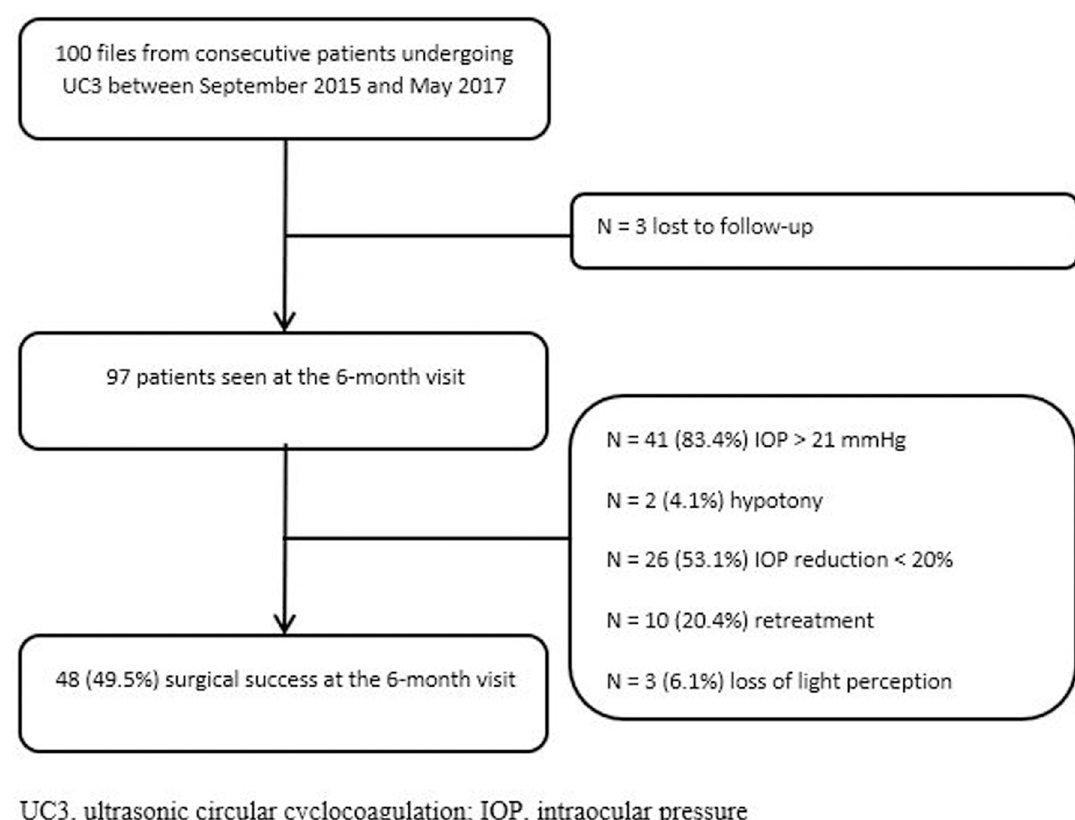
Fig 2. Study flowchart. UC3, ultrasonic circular cyclocoagulation; IOP, intraocular pressure.